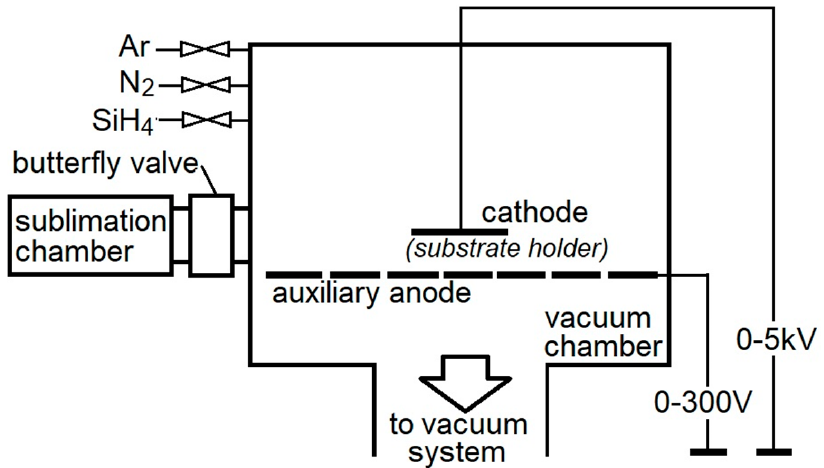
Figure 1. Scheme of the PE CVD equipment used during coating deposition, ZIP 12 type with sublimation chamber.